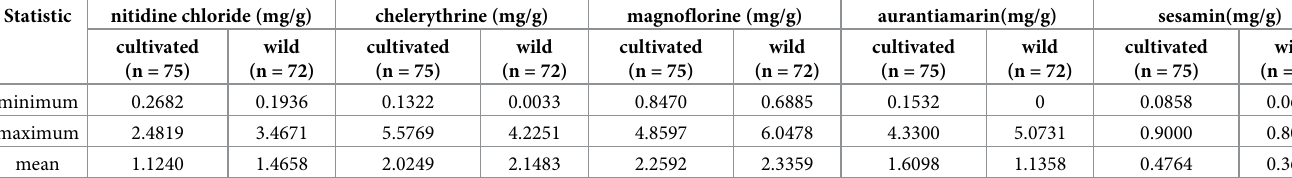
Table 3. Chemical composition of cultivated and wild Z . nitidum measured by UPLC (mg/g). Statistic nitidine chloride (mg/g) chelerythrine (mg/g) magnoflorine (mg/g) aurantiamarin(mg/g) sesamin(mg/g) cultivated wild cultivated wild cultivated wild cultivated wild cultivated wild (n = 75) (n = 72) (n = 75) (n = 72) (n = 75) (n = 72) (n = 75) (n = 72) (n = 75) (n = 72) minimum 0.2682 maximum mean 1.1240